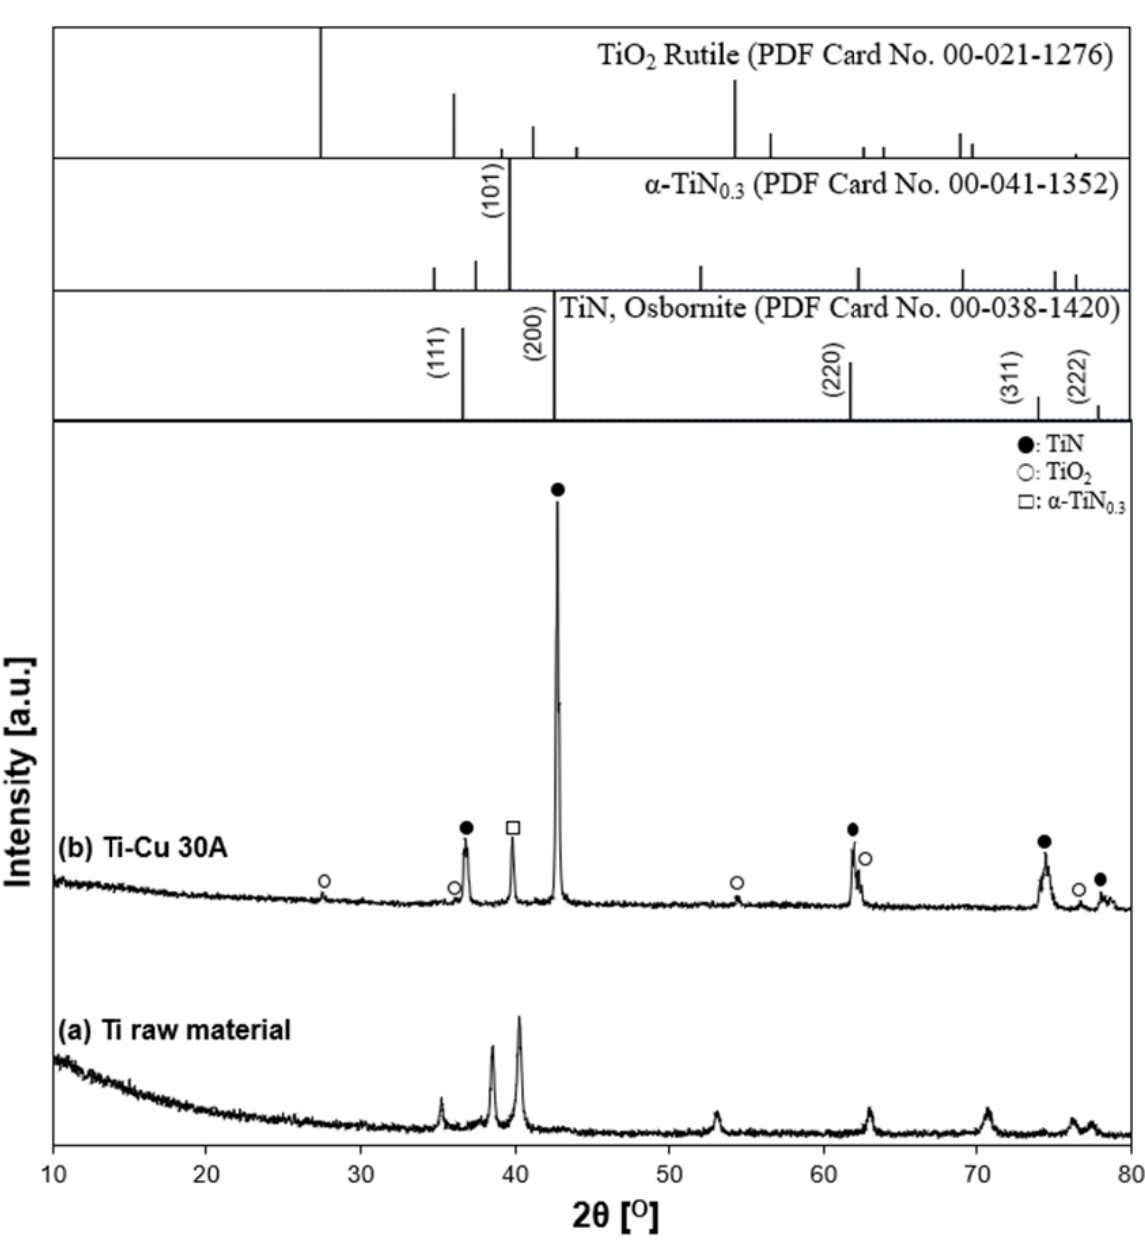
Figure 15. X-ray diffraction patterns of the Ti–Cu sample. ( a ) Ti electrode raw material and ( b ) Ti–Cu 30 A: (●) TiN, ( ○ ) TiO 2 , and (□) α-TiN 0.3.